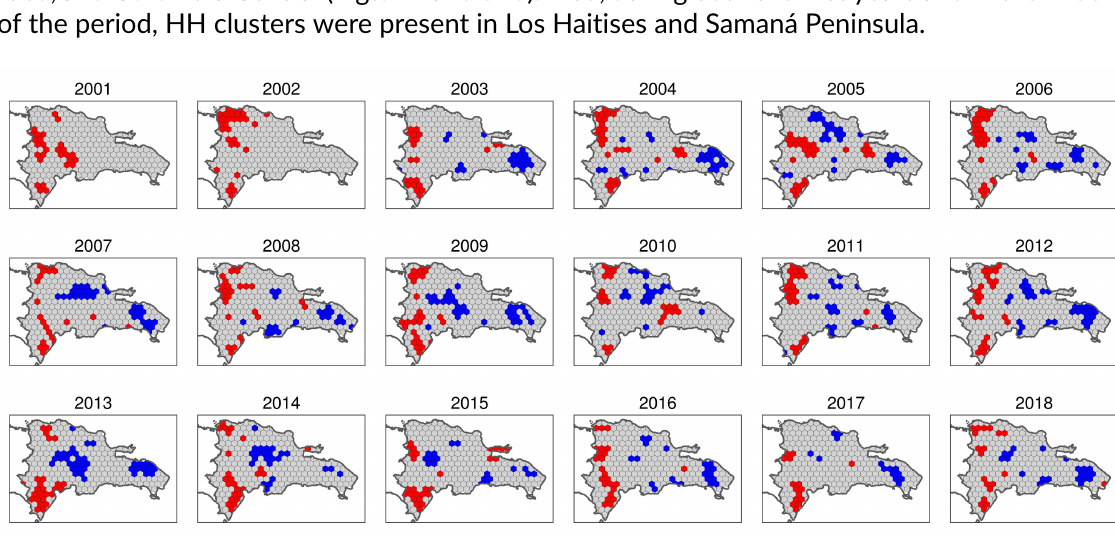
Figure 11 – Yearly LISA maps (local indicators of spatial association maps) of transformed MODIS fire density data. See Figure 9 for colour legend of